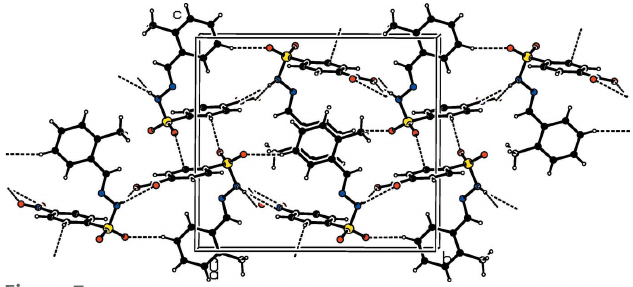
Table 1), N1—H1 N (cid:2) (cid:2) (cid:2) O3 i and N1—H1 N (cid:2) (cid:2) (cid:2) O4 i in (II) (Fig. 9 b ; Table 2) and N1—H1 N (cid:2) (cid:2) (cid:2) O5 i , O5—H51 (cid:2) (cid:2) (cid:2) O2 ii and O5—